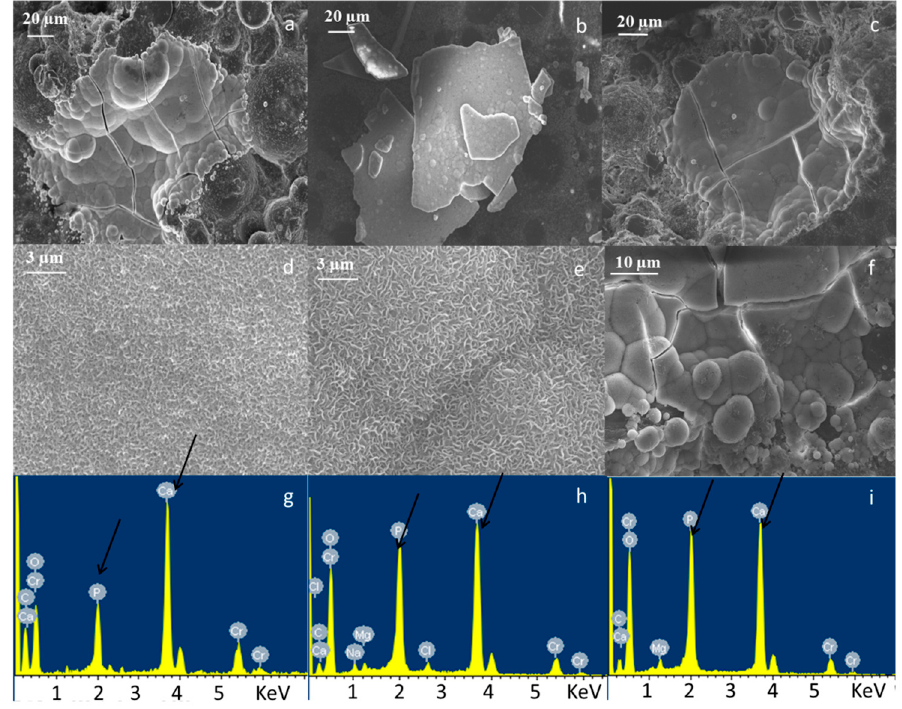
Figure 5. FESEM and EDS analysis of ( a , d , g ) CEMEX ® ISO-Cu, ( b , e , h ) CEMEX ® RX-Cu, and ( c , f , i ) CEMEX ® XL-Cu immersed in SBF solution up to 28 days.